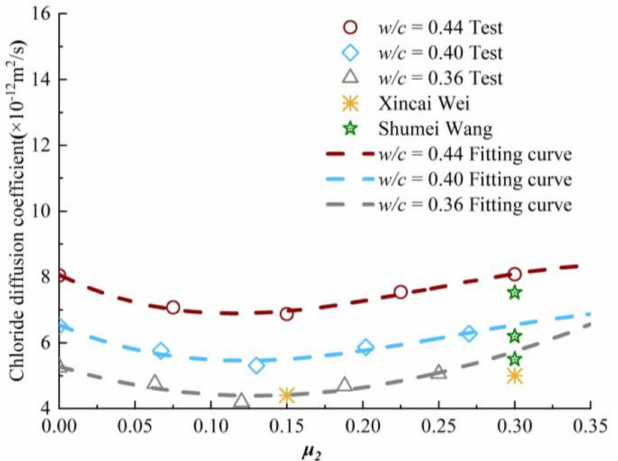
Figure 11. Verification of chloride di ff usion coe ffi cient under biaxial sustained compressive